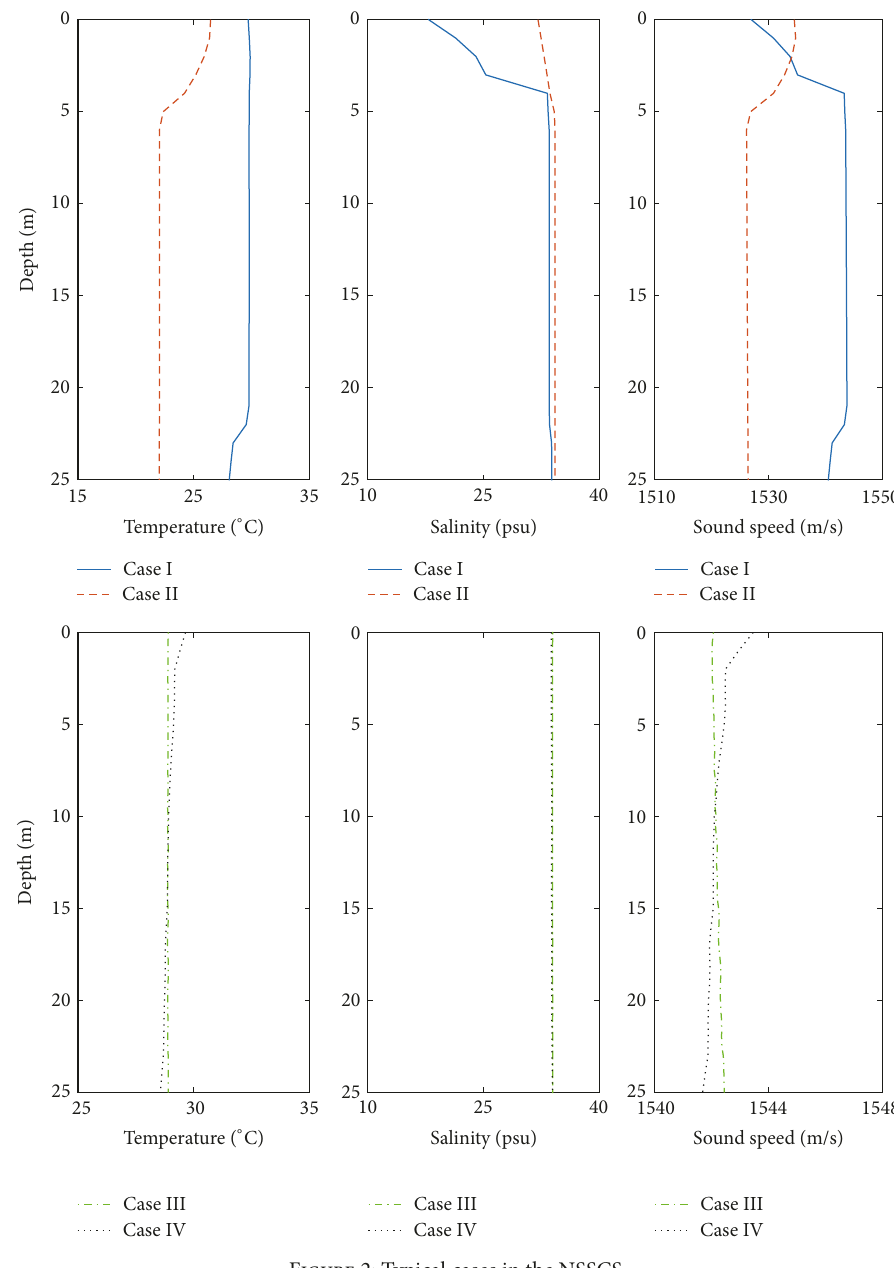
Figure 2: Typical cases in the NSSCS.